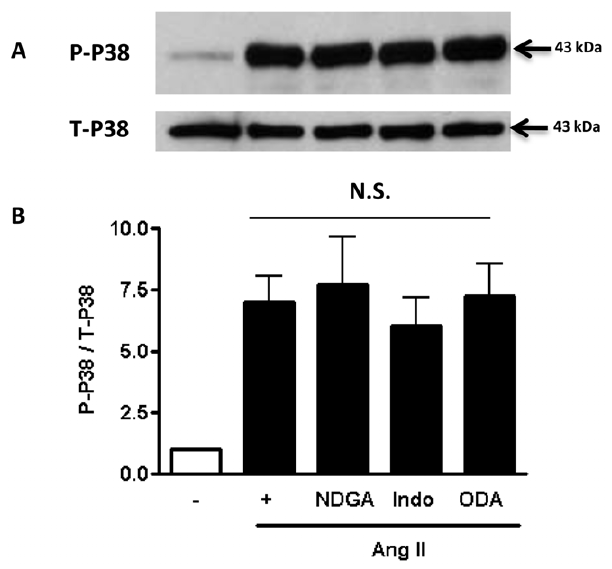
Figure 7. Lack of effects of inhibiting arachidonic acid metabolism on Ang II induced p38 MAPK activation. VSMC were isolated from the aortas of iPLA 2 b -Wt mice and incubated with inhibitors of lipoxygenase (NDGA, 30 m M), cyclooxygenase (Indometh- acin, 50 m M) or P450 cytochrome C (ODA, 10 m M) and stimulated with Ang II (100 nM) or saline for 1 h. Then the total- or phosphorylated p38 MAPK was determined by Western Blot. n=3–4.